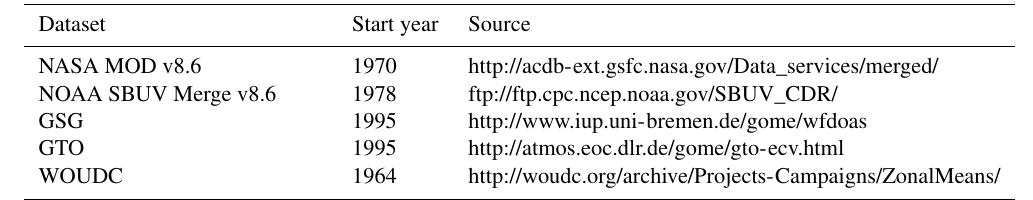
Table 1. Start year and source of merged total ozone